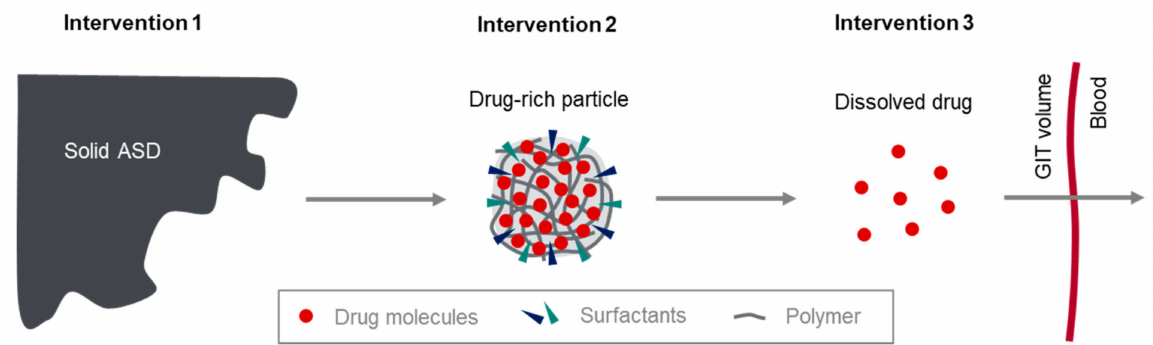
Figure 4. Conceptual model describing the drug release from ASDs, the formation of drug-rich particles, and intestinal absorption of the molecularly dissolved drug. The solid ASD dissolves into drug-rich particles (presumably composed of drug, polymer, and surfactants), from which molecularly dissolved drug is liberated and absorbed (adapted from [28], Taylor & Francis Group,